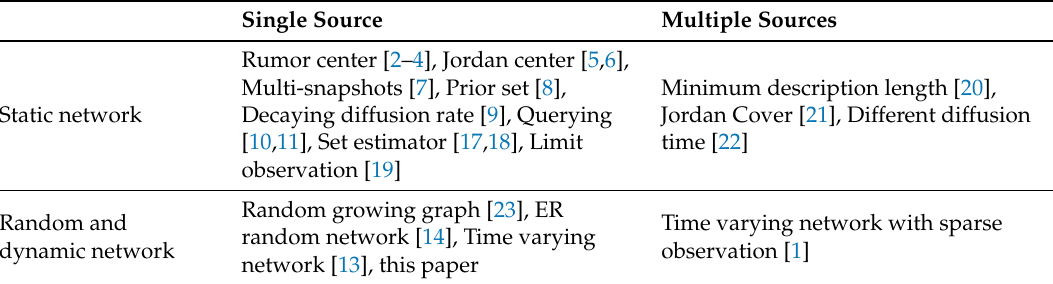
Table 1. Taxonomy of epidemic source detection